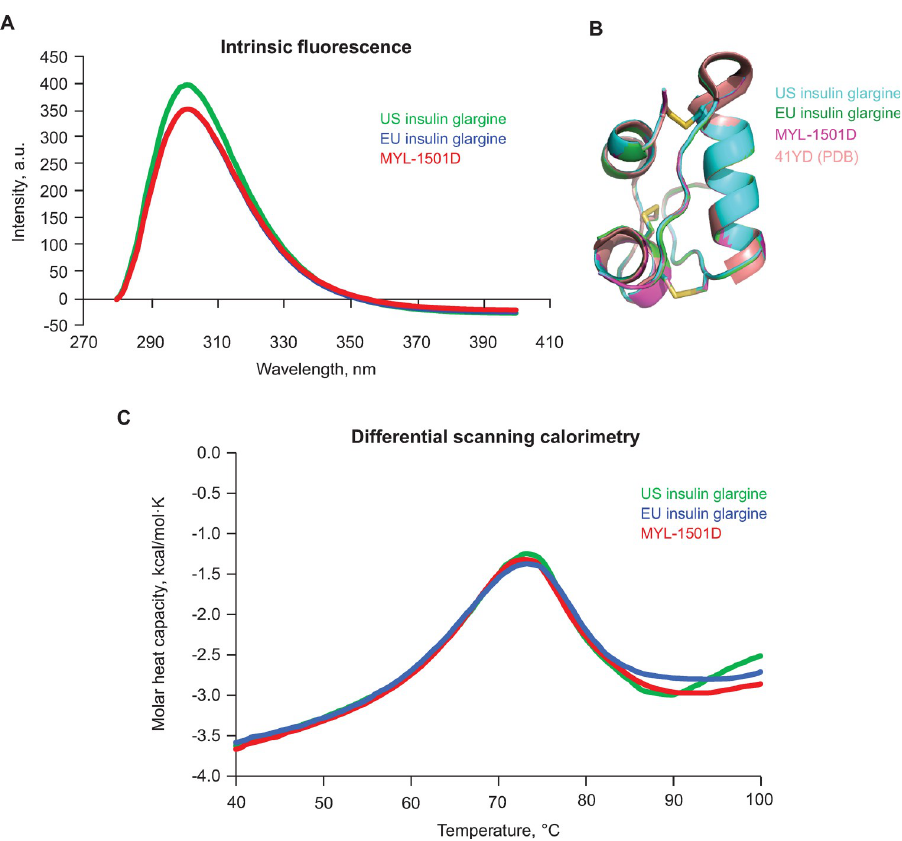
Fig 3. Representative overlay of MYL-1501D, US- and EU-licensed insulin glargine. (A) Intrinsic Fluorescence Spectral Plots (B) Superposition of MYL-1501D X-Ray Structure and Reference Products With Insulin Glargine (4IYD) as the Base. (C) Differential Scanning Calorimetry Profiles of MYL-1501D (Red), US-Licensed Insulin Glargine (Green), and EU-Licensed Insulin Glargine (Blue).